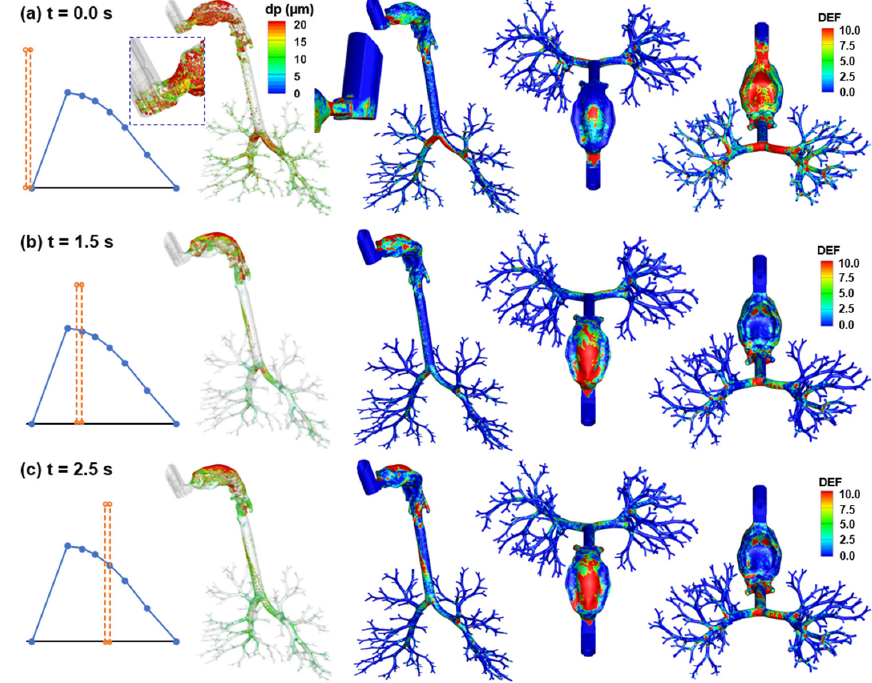
Figure 12. Comparison of surface deposition and DEF maps among three MDI actuation times: ( a ) firing at 0.0 s, ( b ) 1.5 s, and ( c ) 2.5 s.